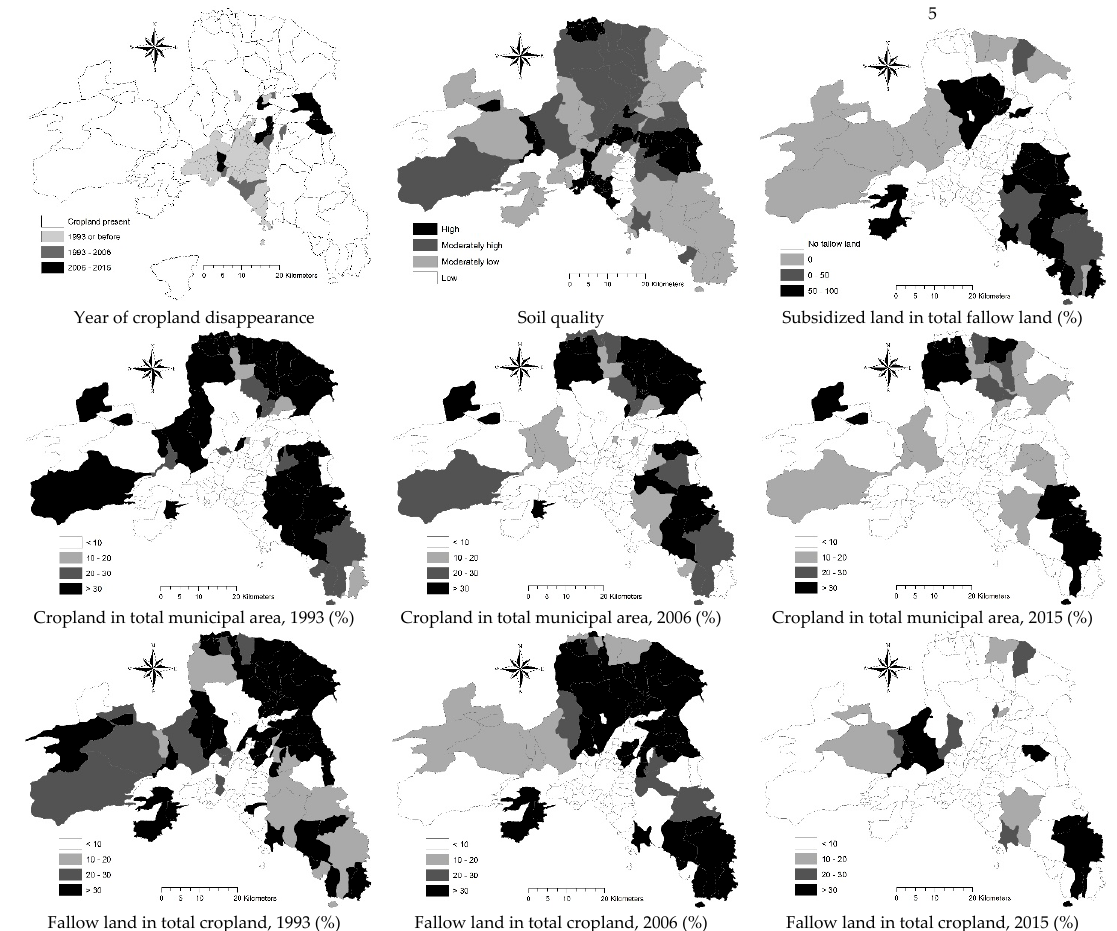
Figure 2. Spatial distribution of selected indicators in the study area.